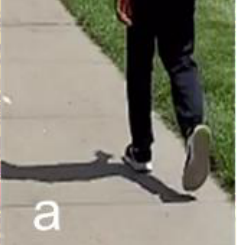
Figure 2. Placement of sensors at three locations on a subject.